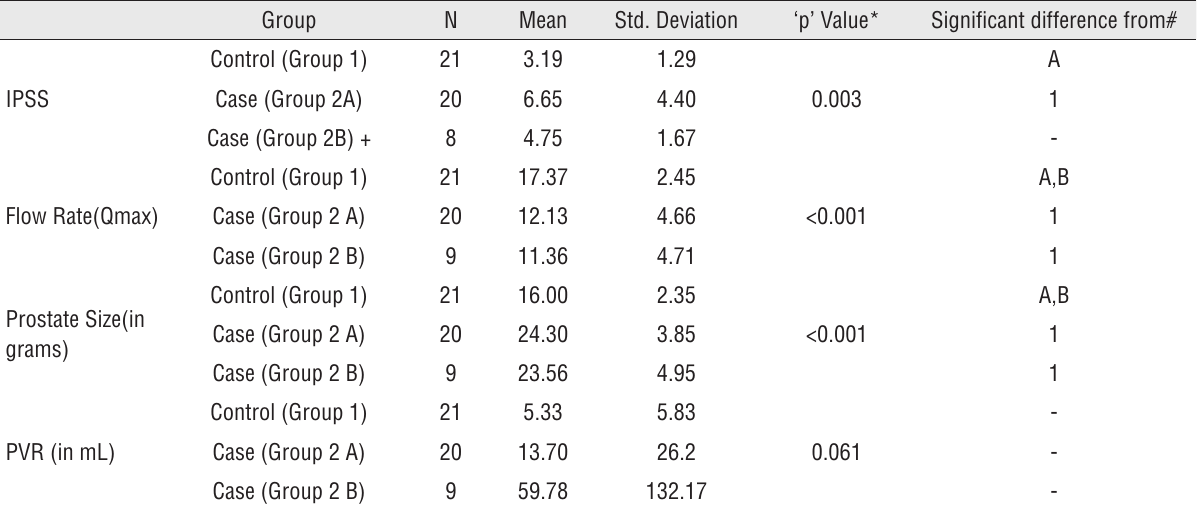
Table 5 - Post operative (at 3 rd months) comparison between